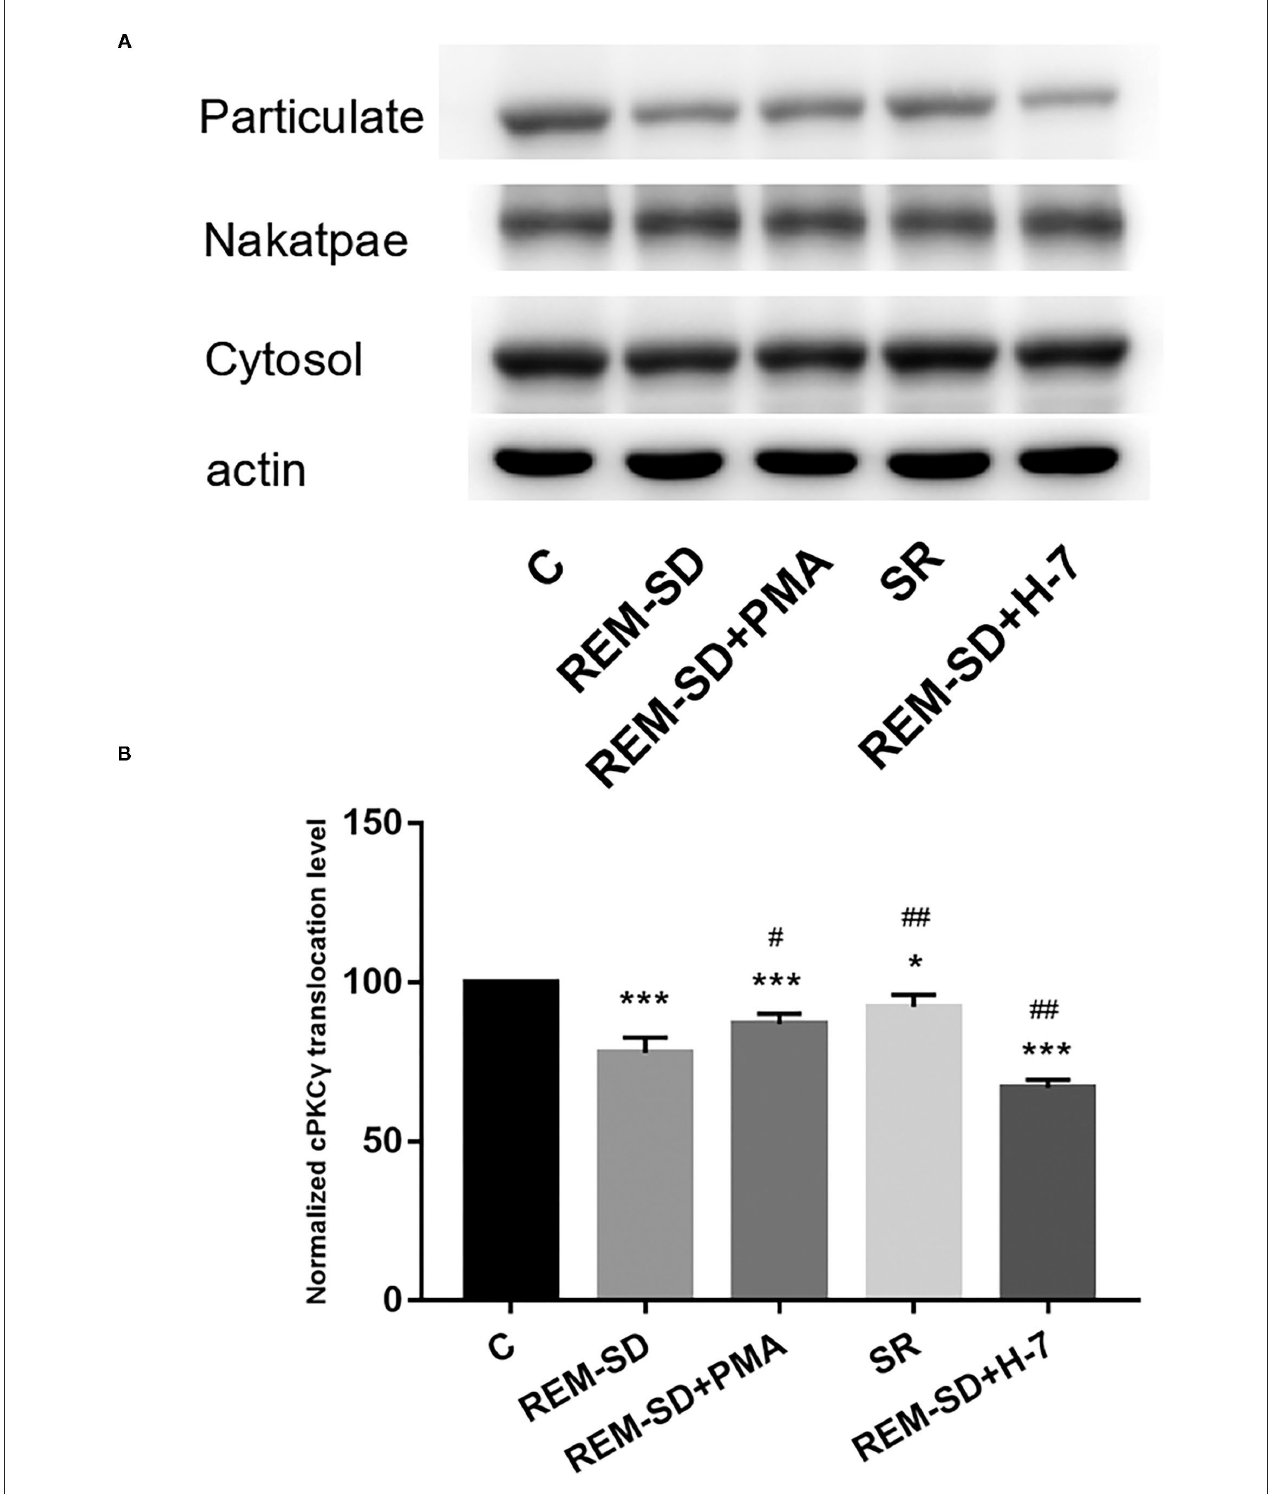
FIGURE 6 | cPKC γ membrane translocation levels in the prefrontal cortex of SD rats from each group and control group (C). (A) Western blot analysis results. Cytosol and particulate-represented cytosolic and membrane proteins, respectively. (B) cPKC γ membrane translocation levels for each group. * P < 0.05, *** P < 0.001 vs. control; # P < 0.05, ## P < 0.01, vs. SD